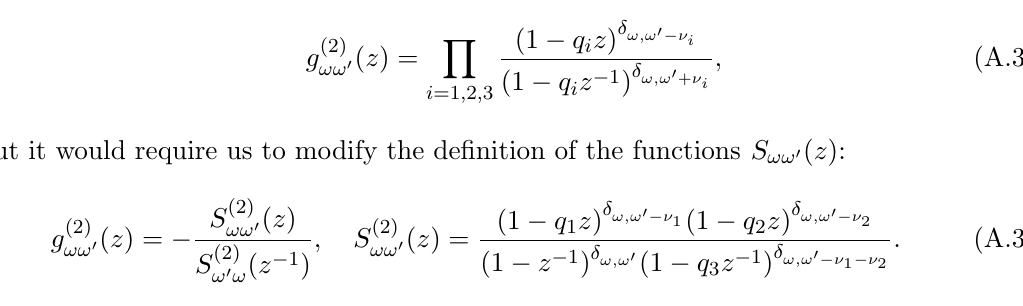
Figure 1 . Generic and degenerate con(cid:12)gurations of a box added to the corner of a Young diagram. positive and negative currents, and makes the de(cid:12)nition of the central charge (cid:22) c more di(cid:14)cult. Note also that another possibility could have been to